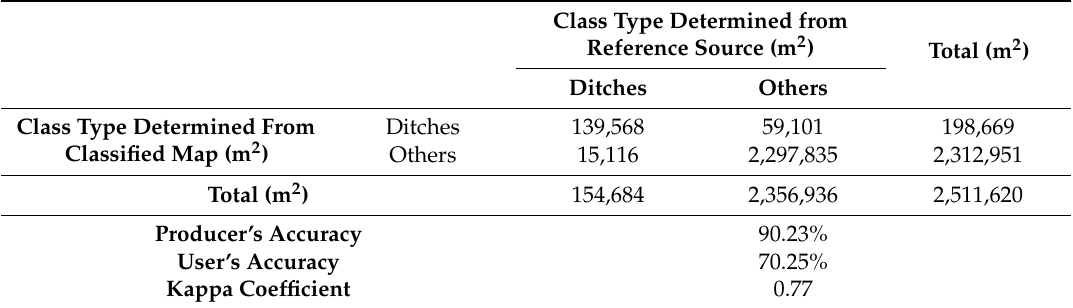
Table 4. Accuracy assessment of ditch results from the research area determined from similarity matrix. Reference sources are 20 visually interpreted reference areas, each a 20 m radius circle.